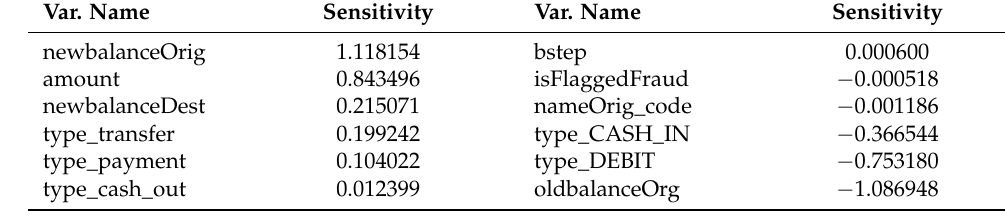
Table 5. Mean of sensitivity for each feature in PaySim Dataset.